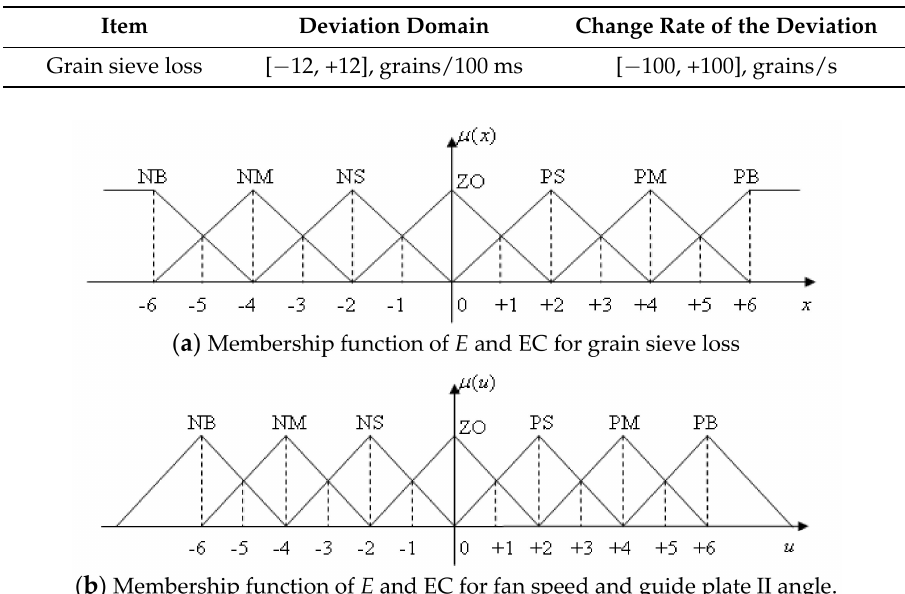
Table 6. Changing range of the cleaning performance.